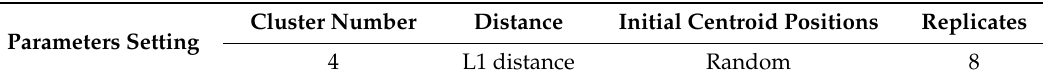
Table 2. Parameters in k-means.